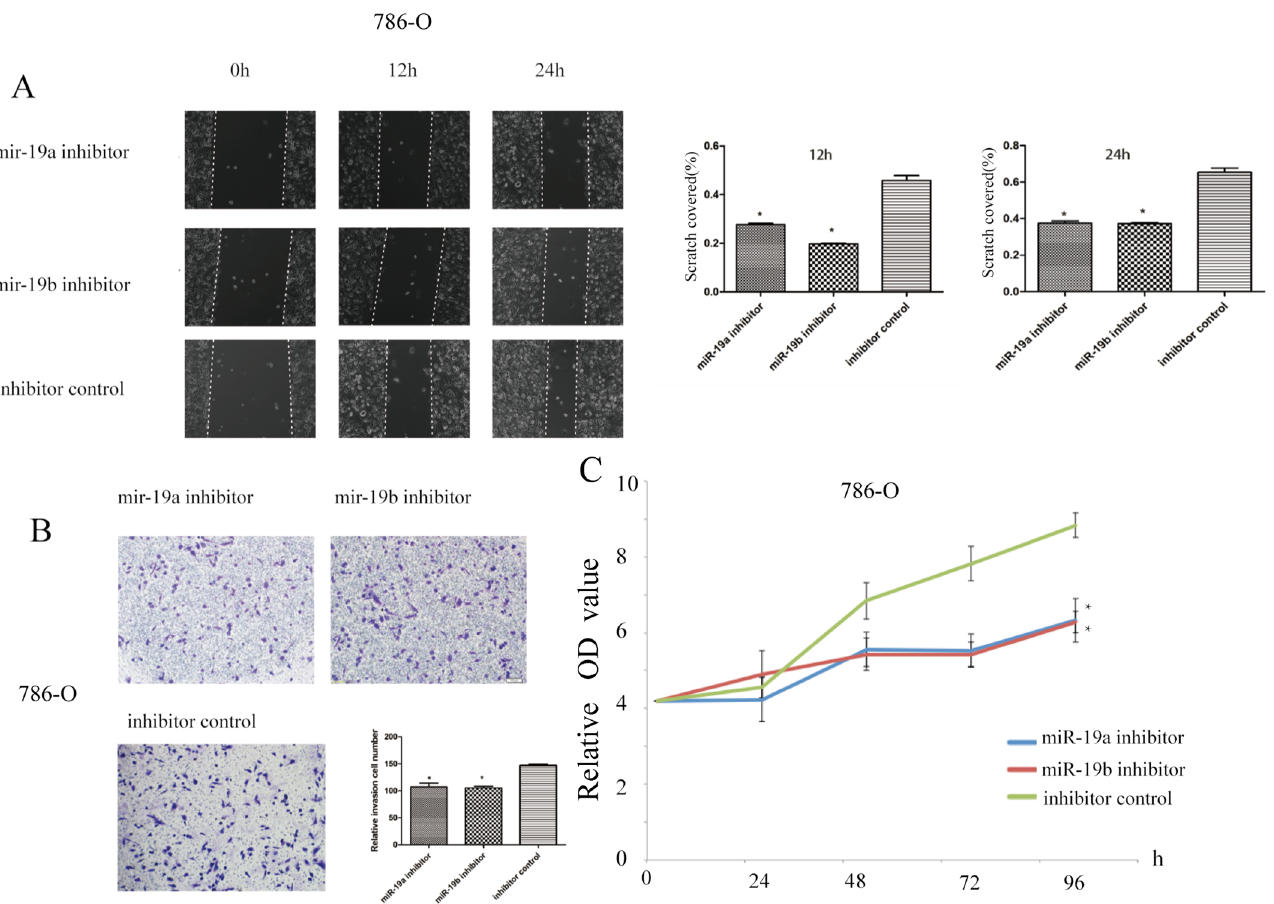
Fig 4. MiR-19a and miR-19b inhibitors reduce cell migration and invasiveness, and inhibit cell proliferation. (A) Representative images showing that the transfection of miR-19a and miR-19b inhibitors decreases the migration of 786-O cells by wound healing assay (Left); quantification of relative migration at 12 and 24 h (Right). (B) Representative images and quantification of relative migration, showing that the transfection of miR-19a and miR-19b inhibitors reduces the invasiveness of 786-O cells by transwell assay. The migratory activities of 786-O cells transfected with control oligo were was included as a negative inhibitor control. (C) The proliferation potential of 786-O cells transfected with miR-19a and miR-19b inhibitors or control oligo was determined by the MTS Assay. The data are representative of three independent experiments. (cid:3) Significant differences from control oligo-transfected cells (P < 0.05).